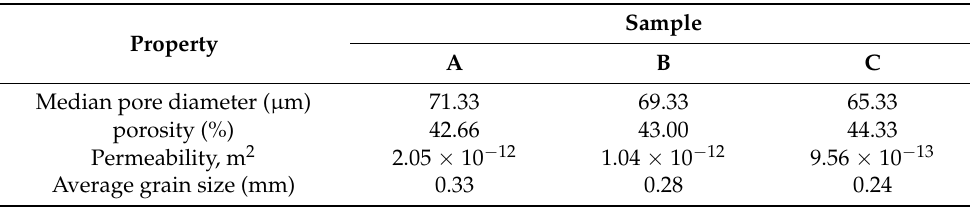
Table 6. Permeability of samples A, B and C presented along with the average porosimetry data for the three samples. Sample Property A B C Median pore diameter ( µ m) 71.33 69.33 65.33 porosity (%) 42.66 43.00 44.33 Permeability, m 2 2.05 × 10 − 12